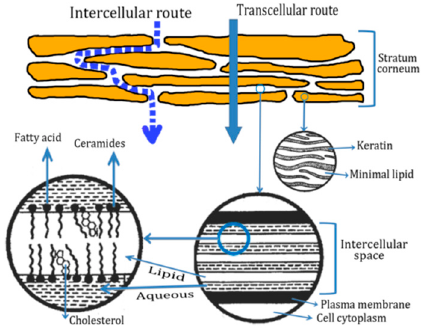
Figure 2. Schematic representation of stratum corneum and two micro routes for peptide penetration. Adapted from [30].